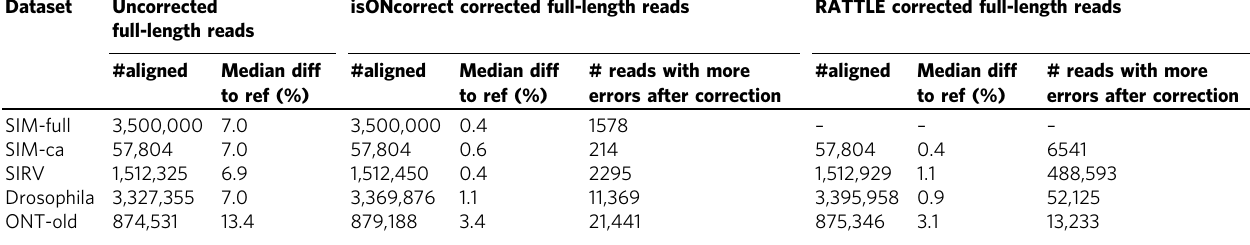
Table 2 Read statistics before and after error